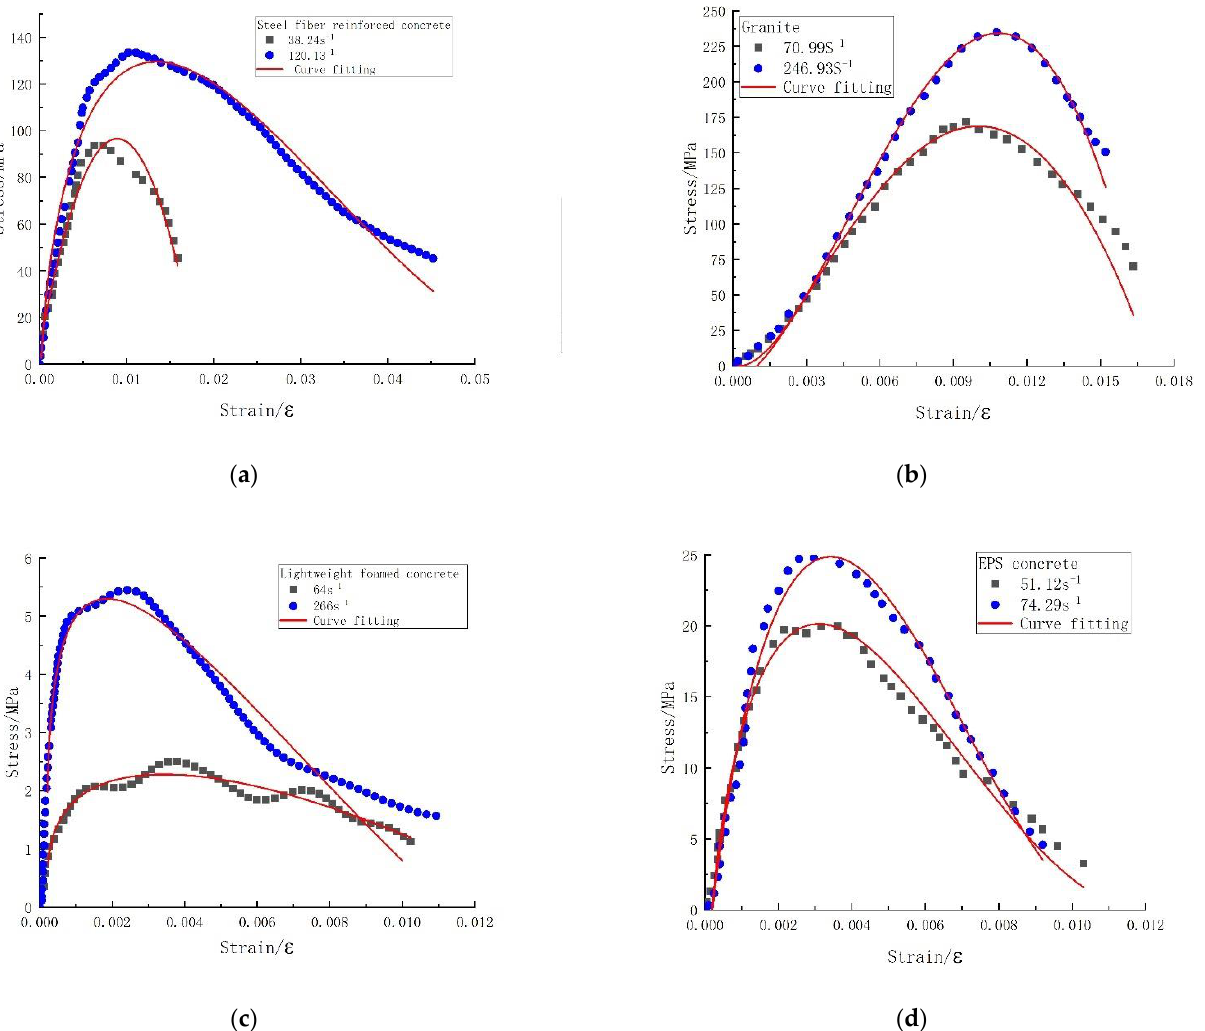
Figure 17. Curve fitting. ( a ) Steel fiber reinforced concrete; ( b ) Granite; ( c ) Lightweight foramed concrete; ( d ) EPS concrete. Table 3. Fitted curve parameters.